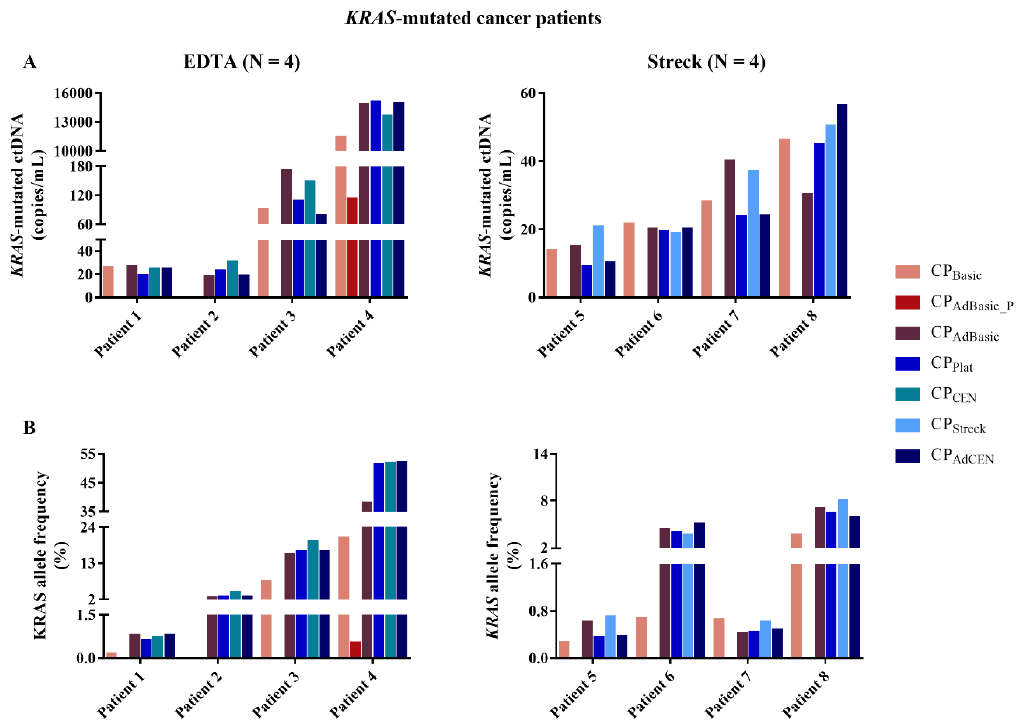
Figure 3. ctDNA analysis of KRAS -mutated metastatic cancer patients (8) per centrifugation protocol (Table 1) in EDTA (left) and Streck (right) tubes. ( A ) Concentration of KRAS -mutated ctDNA (copies/mL); ( B ) KRAS -mutated ctDNA allele frequency (%); N: number of participants.